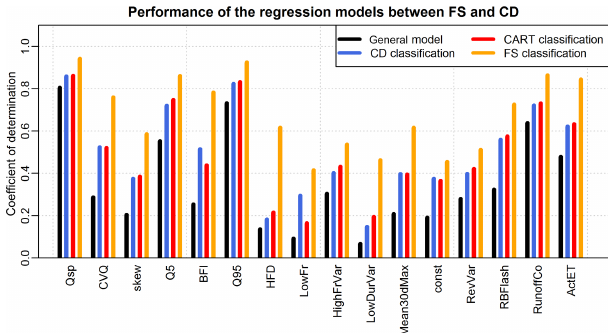
Figure 4. Performance of regression models when calibrated for each flow signature (Table 2) and applied over the whole domain with a general model or one per class, using catchment classifica- tion based on catchment descriptors (CD), flow signatures (FS) or regression trees (CART). Performance is evaluated over the whole set of flow gauges together even if different models are used in dif- ferent